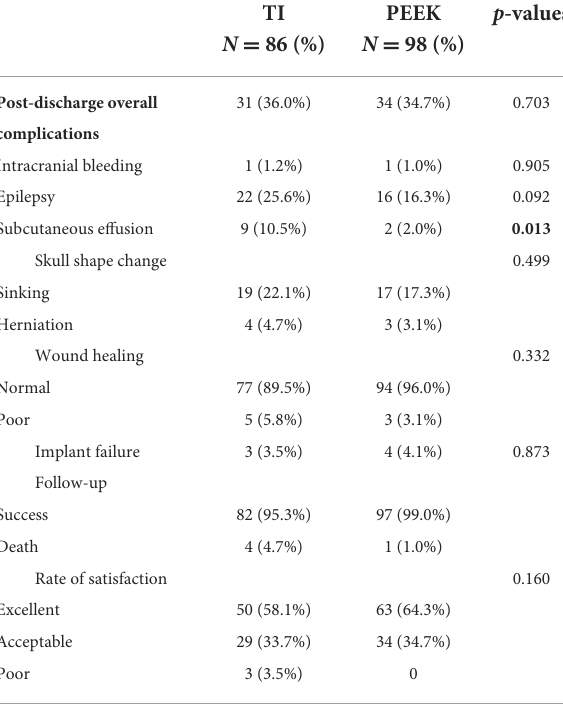
TABLE 4 Post-discharge complication between TI group and PEEK group.